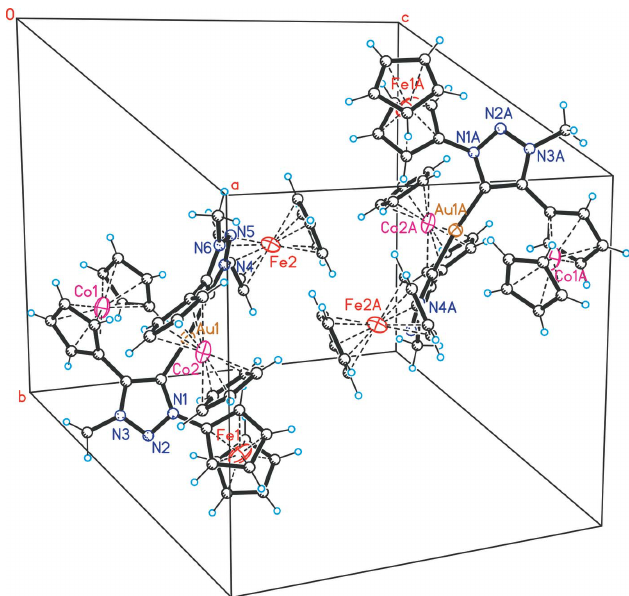
Figure 2 The arrangement of molecular entities of the tricationic title compound in the unit cell (the counter-ions were omitted for clarity). [Symmetry code: 1 (cid:3) x , 1 (cid:3) y , 1 (cid:3) z